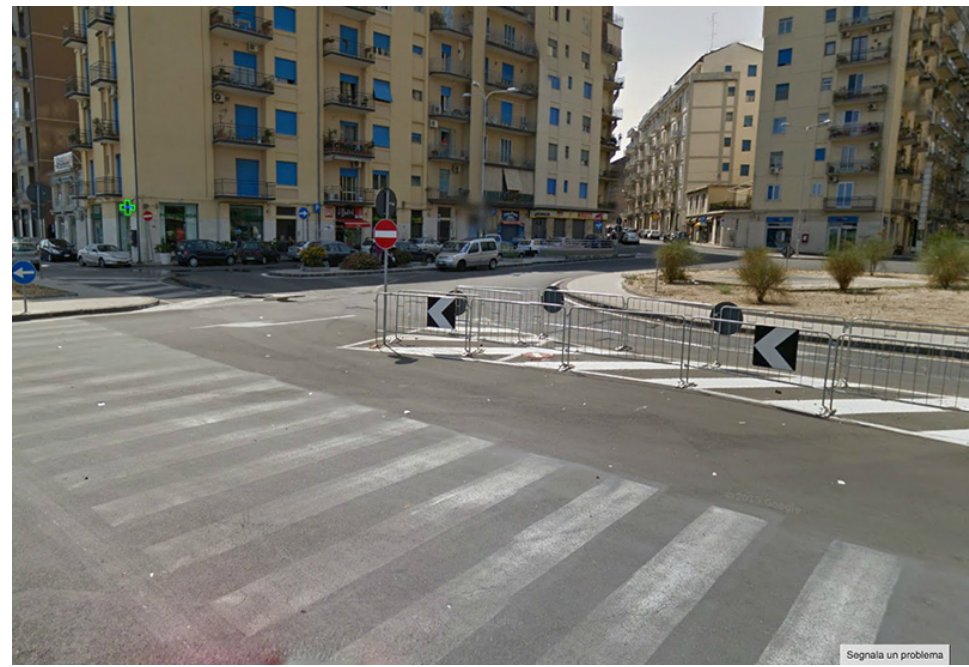
Figure 8. Piazza Galatea - Catania (before).